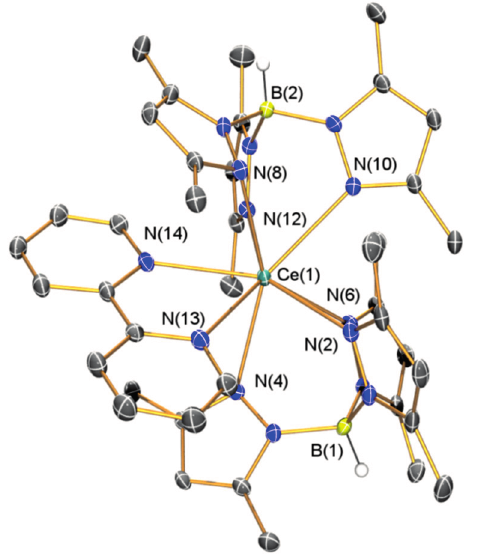
Figure 2. Molecular structure of 2 ·(C 4 H 8 O) 2 with selective atom labeling. Displacement ellipsoids set at 30% probability level and hydrogen atoms (except B–H) and lattice solvent omitted for